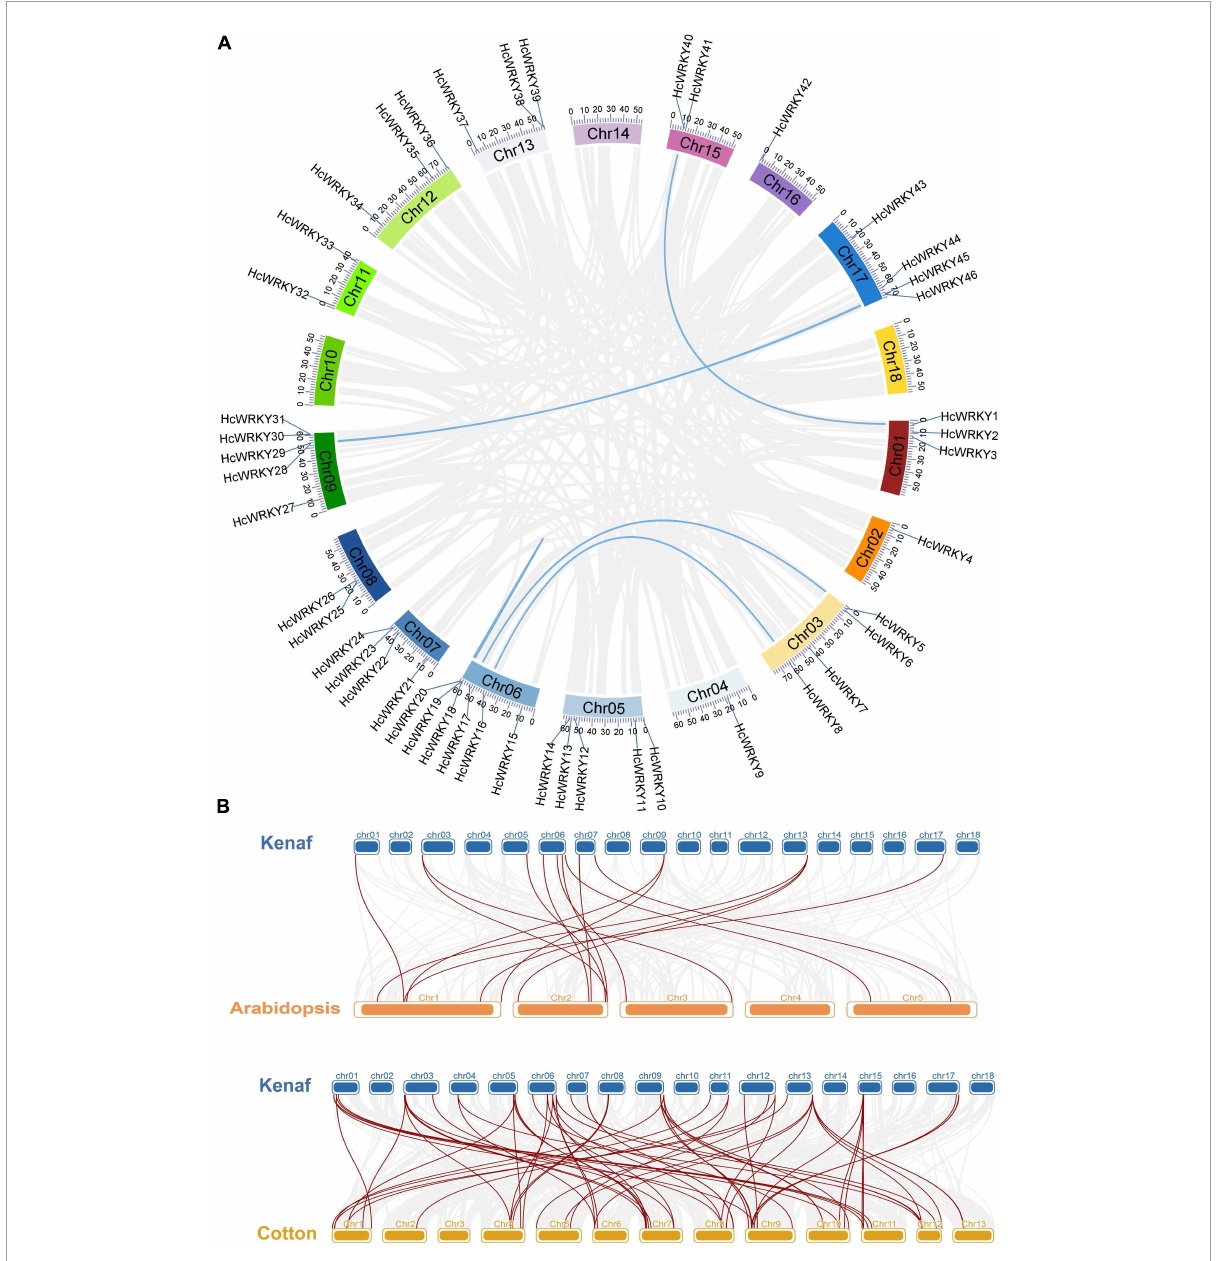
FIGURE3 Collinearity analysis for all HcWRKYs . (A) HcWRKY genes mapped onto the corresponding chromosomes position of kenaf, as shown in different colors, were used for their collinearity analysis. (B) Synteny analysis among the Arabidopsis , kenaf and cotton.